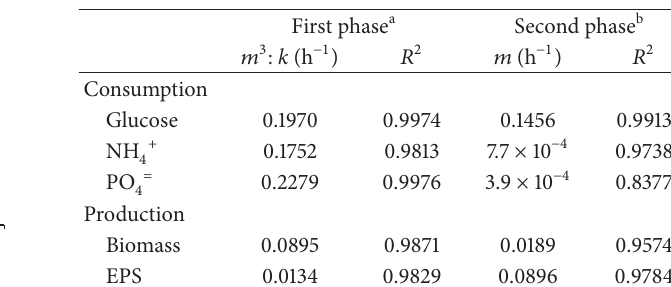
Table 4: Kinetic parameters for EPS production from glucose (2L Bioreactor; C/N ratio, 100; medium, NL) calculated using Kaleida- Graph software